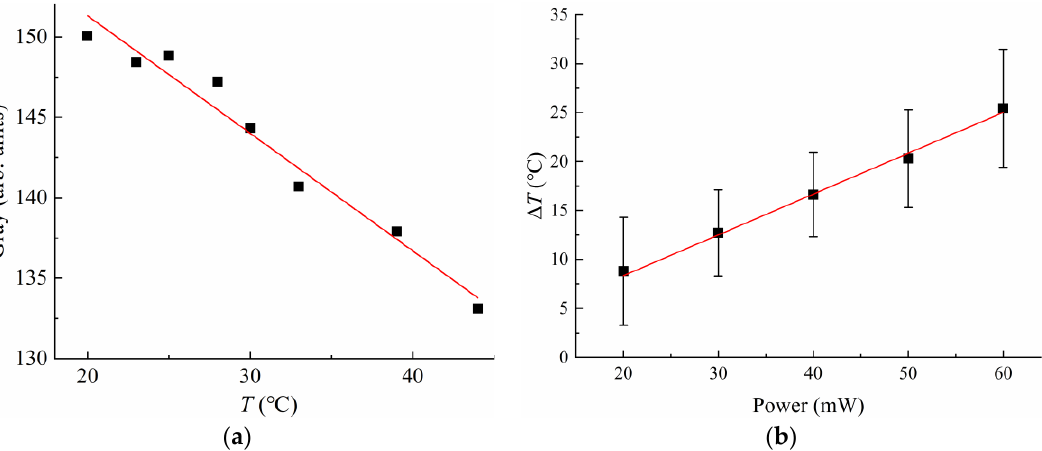
Figure 2. ( a ) Gray value at different temperature; ( b ) Temperature increases with different power.